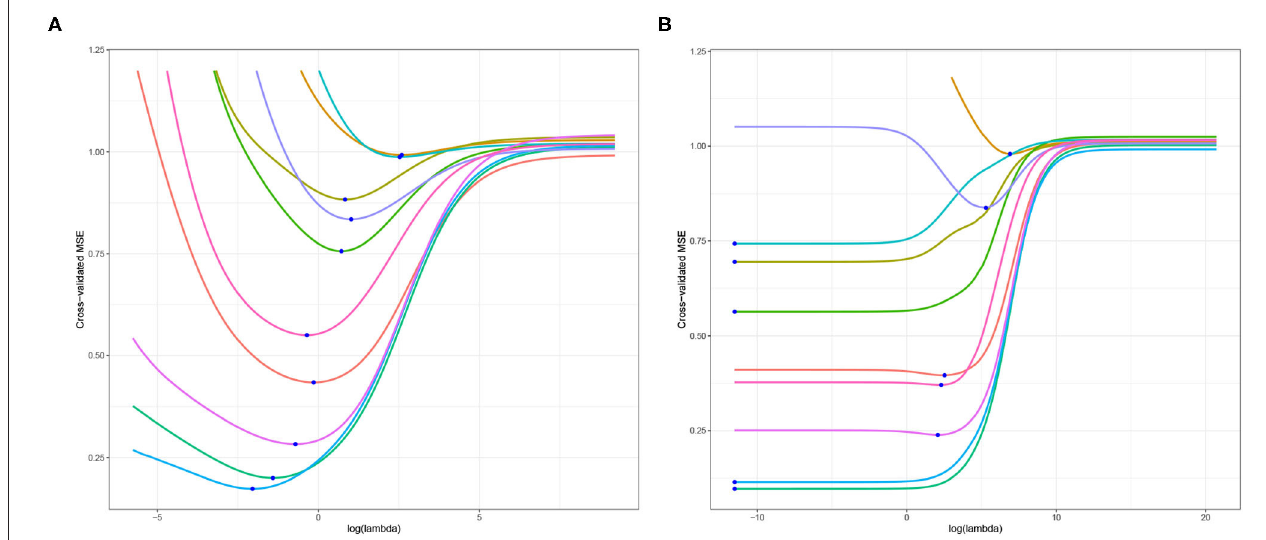
FIGURE 1 | Cross-validated MSE of ridge regression using (A) n = 64 and p = 50 randomly selected explanatory variables; (B) n = 64 and p = 3,116, all explanatory variables. The blue dot corresponds to the minimum cross-validated MSE for each dependent variable.